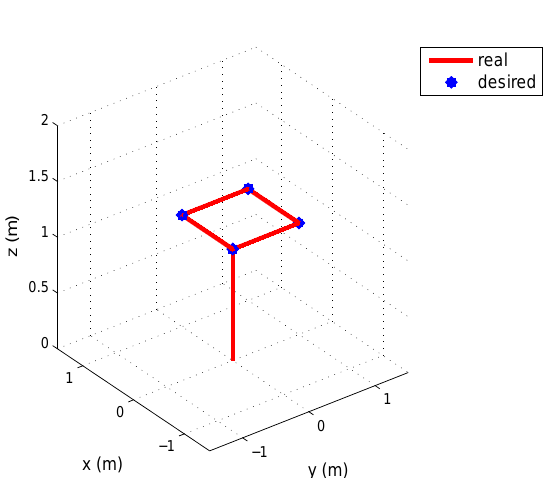
Figure 8. Control inputs.